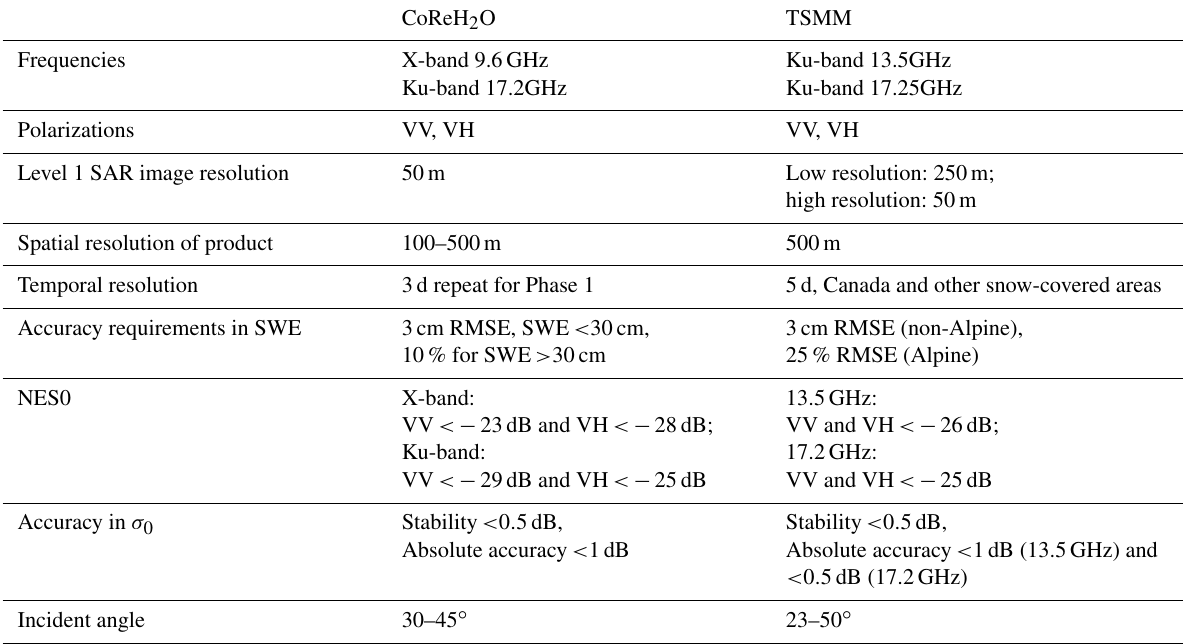
Table 5. Summary of CoReH 2 O and TSMM